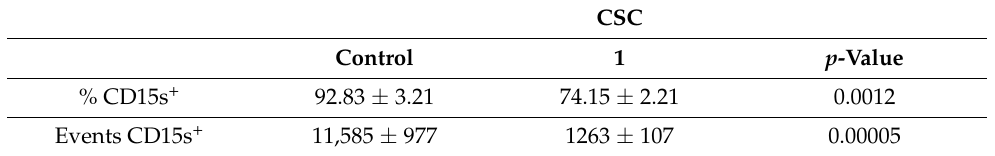
Table 1. Percentage and events of CD15s in CSC after treatment with compound 1